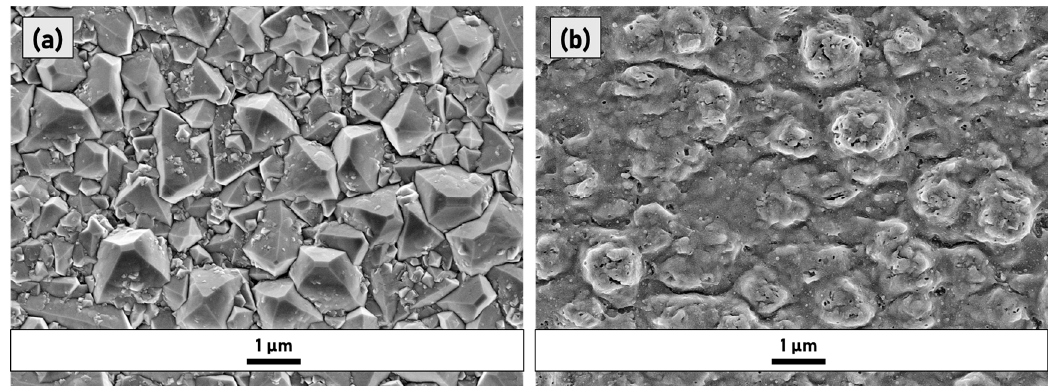
Figure 1. SEM micrographs of ( a ) the pristine (untreated) sample and ( b ) the sample P1.